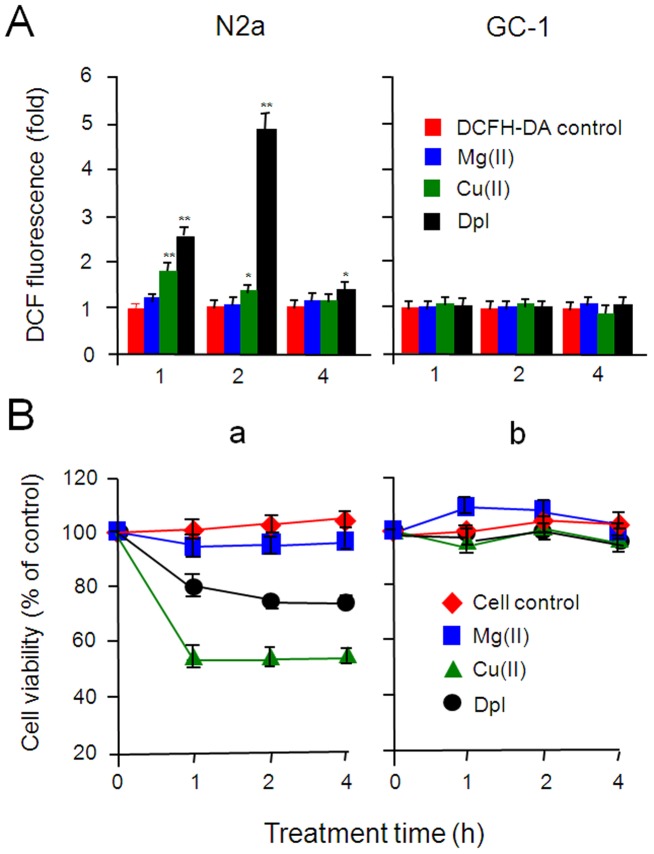
Dpl induces ROS accumulation and acute cell death in N2a but not in GC-1 spg cells.A. Dpl induces ROS accumulation. N2a (a) or GC-1 spg cells (b) in 96-well plates were incubated with 50 µM DCFH-DA for 45 min. After wash, cells were then incubated without or with MgCl2 (100 µM), CuCl2 (100 µM) or the purified mouse Dpl protein (20 µg/ml) for 1, 2 or 4 h. After wash, DCF fluorescence was determined at an excitation of 485 nm and emission of 538 nm by a microplate-reader. The readings of DCF fluorescence of each test group were normalized against that of the DCFH-DA control group and expressed as relative-fold change. Bars are means ± SD of 3 independent experiments. Student t test was used for statistic analyses (*, p<0.05; **, p<0.01). B. Dpl induces acute cell death. N2a (a) or GC-1 spg cells (b) in 96-well plates were incubated without or with MgCl2 (100 µM), CuCl2 (100 µM), or the purified Dpl (20 µg/ml) for 0, 1, 2, or 4 h. The cell growth curves were determined by MTT assay. Bars are means ± SD of 3 independent experiments. Student t test was used for statistic analyses.